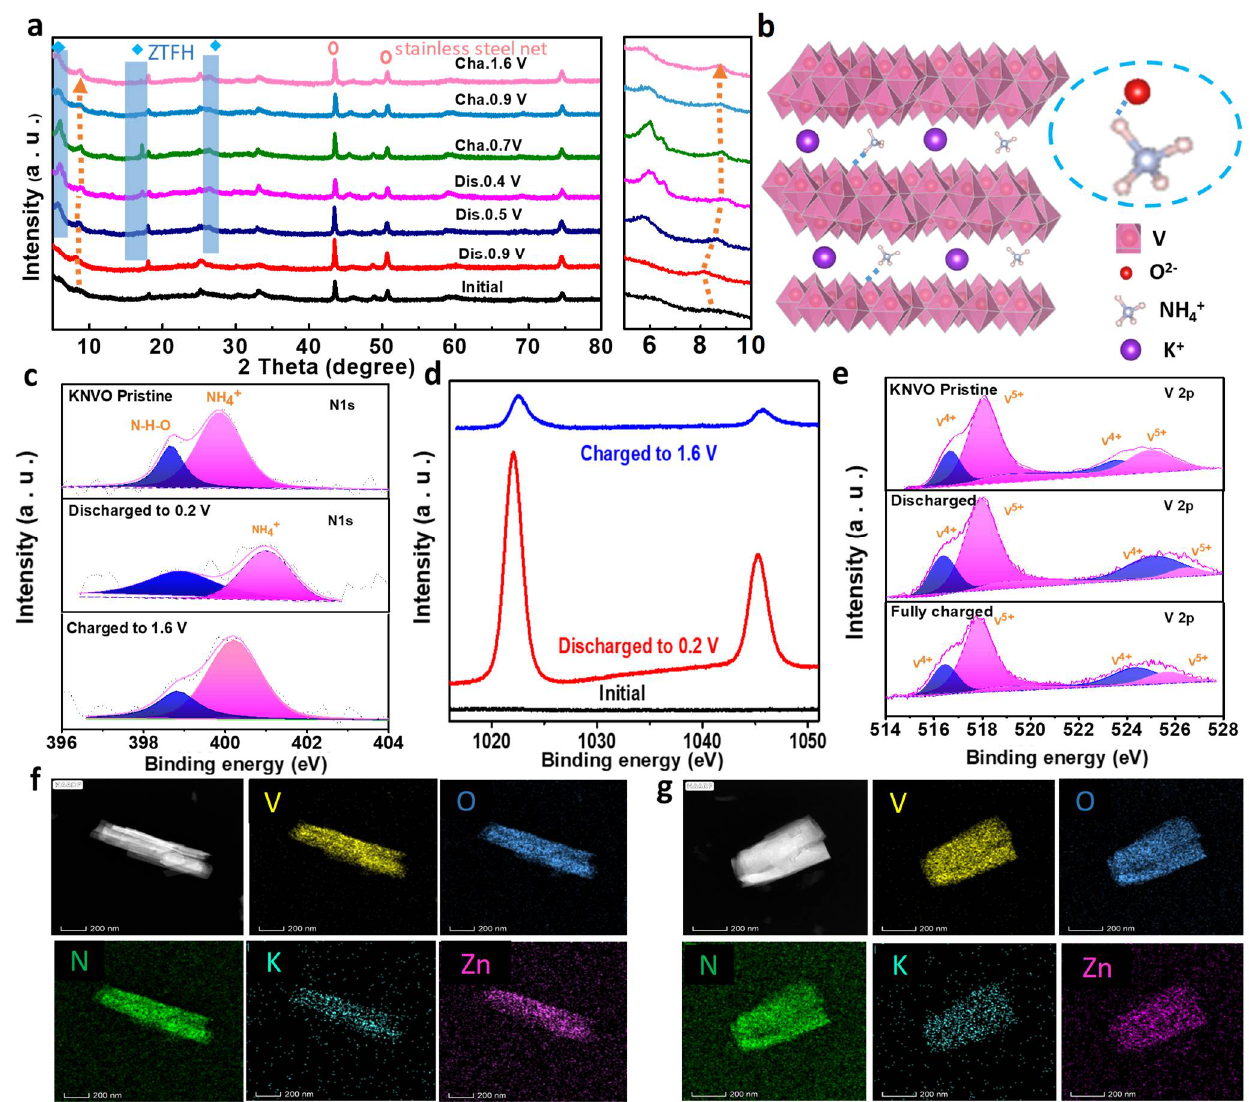
Figure 4. ( a ) The ex situ XRD (the enlarged XRD) pattern of KNVO. ( b ) Crystal structural illustration of KNVO and hydrogen bond formation in KNVO. ( c ) N1s XPS spectrum of KNVO. ( d ) Zn 2p XPS spectrum of KNVO in initial, discharged, and charged state, respectively. ( e ) V2p XPS spectrum of KNVO in initial, discharge, and charge state, respectively. ( f , g ) SEM image of KNVO in discharge, and charge state, respectively.